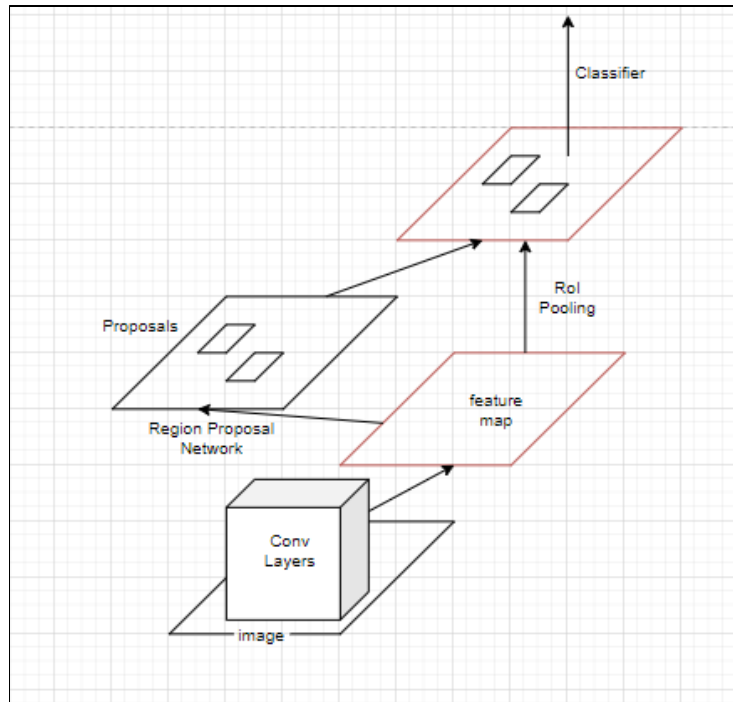
Figure 6. The working of a Faster